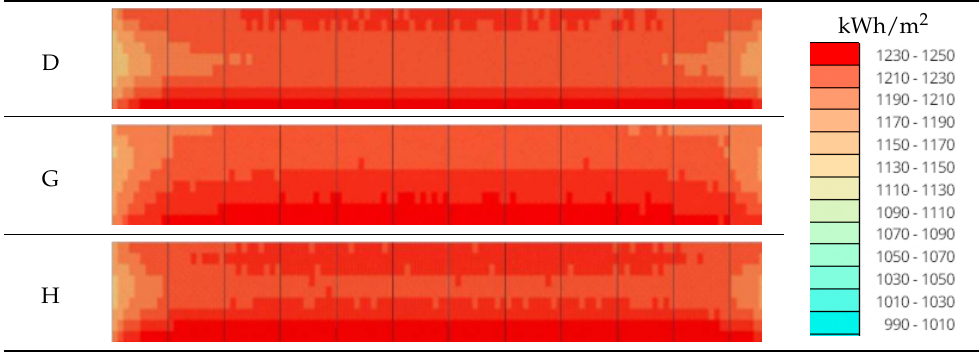
Table 9. Distribution of annual solar irradiance for rows consisting of twelve PV panels positioned vertically for D, H and G cases.